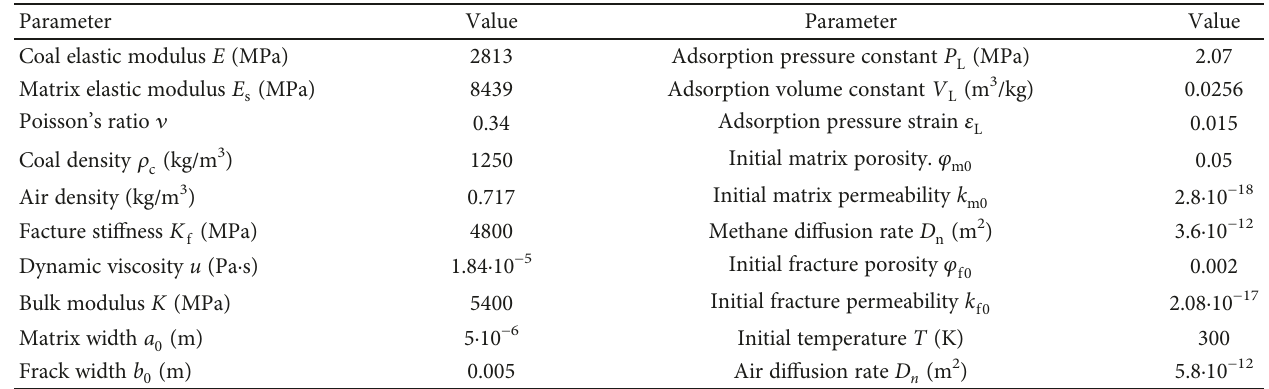
Figure 4: Numerical model of methane extraction in 4102 working face. Table 1: Numerical model physical